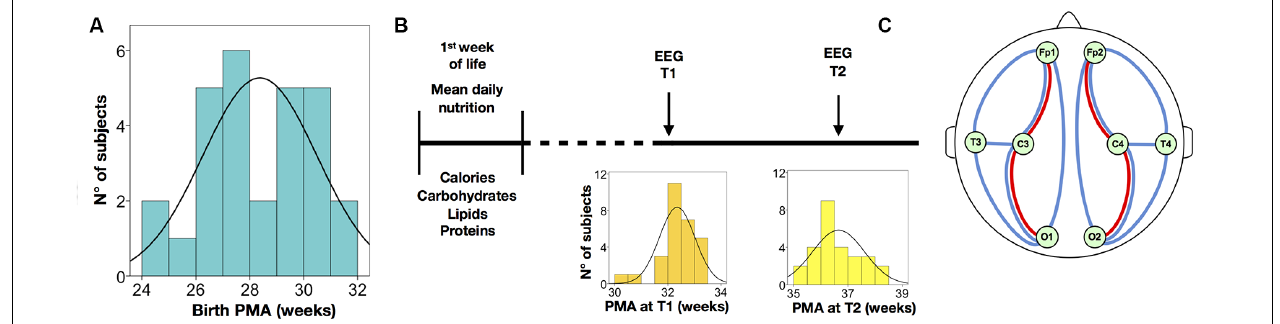
FIGURE 1 | Summary of the study protocol and electroencephalography (EEG) analysis. (A) Distribution of postmenstrual age at birth. (B) Timeline of nutritional data and EEG assessments; the distribution of post-menstrual age (PMA) is displayed at the EEG at T1 and T2, respectively. (C) Schematic drawing of the electrode placement used in the study; the bipolar derivations depict signals used for quantifying interburst interval (IBI; red lines) and activation synchrony index (ASI; blue lines); spectral analyses were calculated from all electrodes; ASI and IBI were also estimated from all electrode pairs.